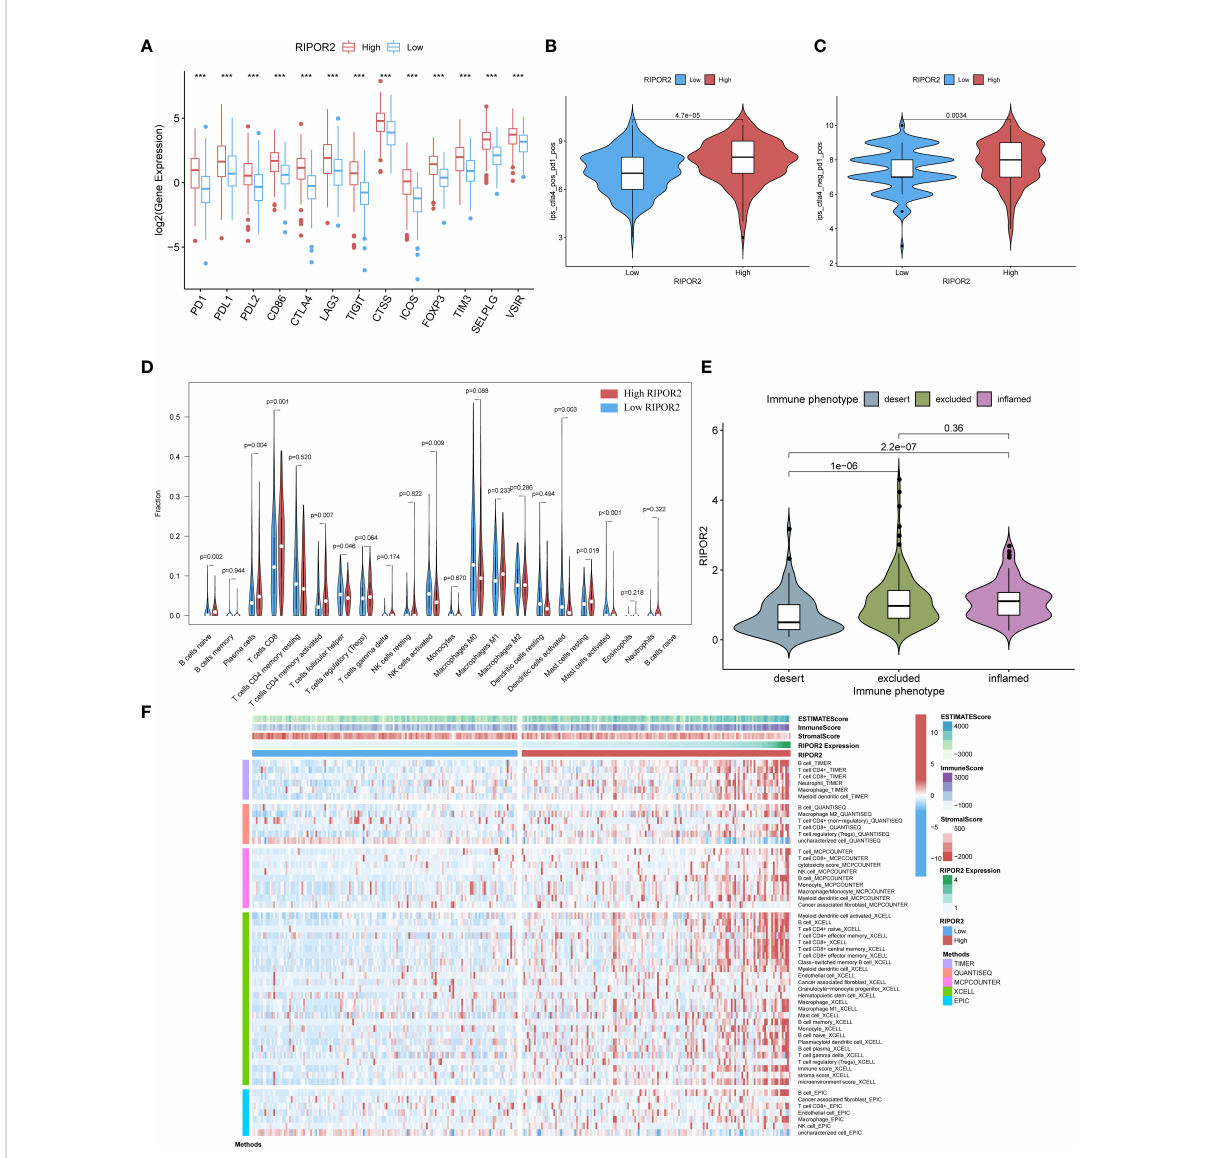
FIGURE 6 (A) The expression of ICPs concerning RIPOR2 was displayed (p-Value: *** p < 0.001). The high expression group responded better under the operation of immunotherapy with PD1 combined with CTLA4 (B) or applied alone (C) . (D) The CIBERSORT result was shown in the comparison between low- and high-RIPOR2 groups by violin plot. (E) A statistic on the immune phenotype distribution in different RIPOR2 expression levels comprising “ desert, ” “ excluded, ” and “ in fl amed ” were depicted. Patients with low expression of RIPOR2 tend have with the desert phenotype. (F) Multialgorithm analytical results on immune cells of tumor microenvironment (TME) in cervical cancer, including existing data from platform TIMER, XCELL, MCP-counter, quanTIseq, and EPIC. The top-bars show the distribution of TME-related scores along with the RIPOR2